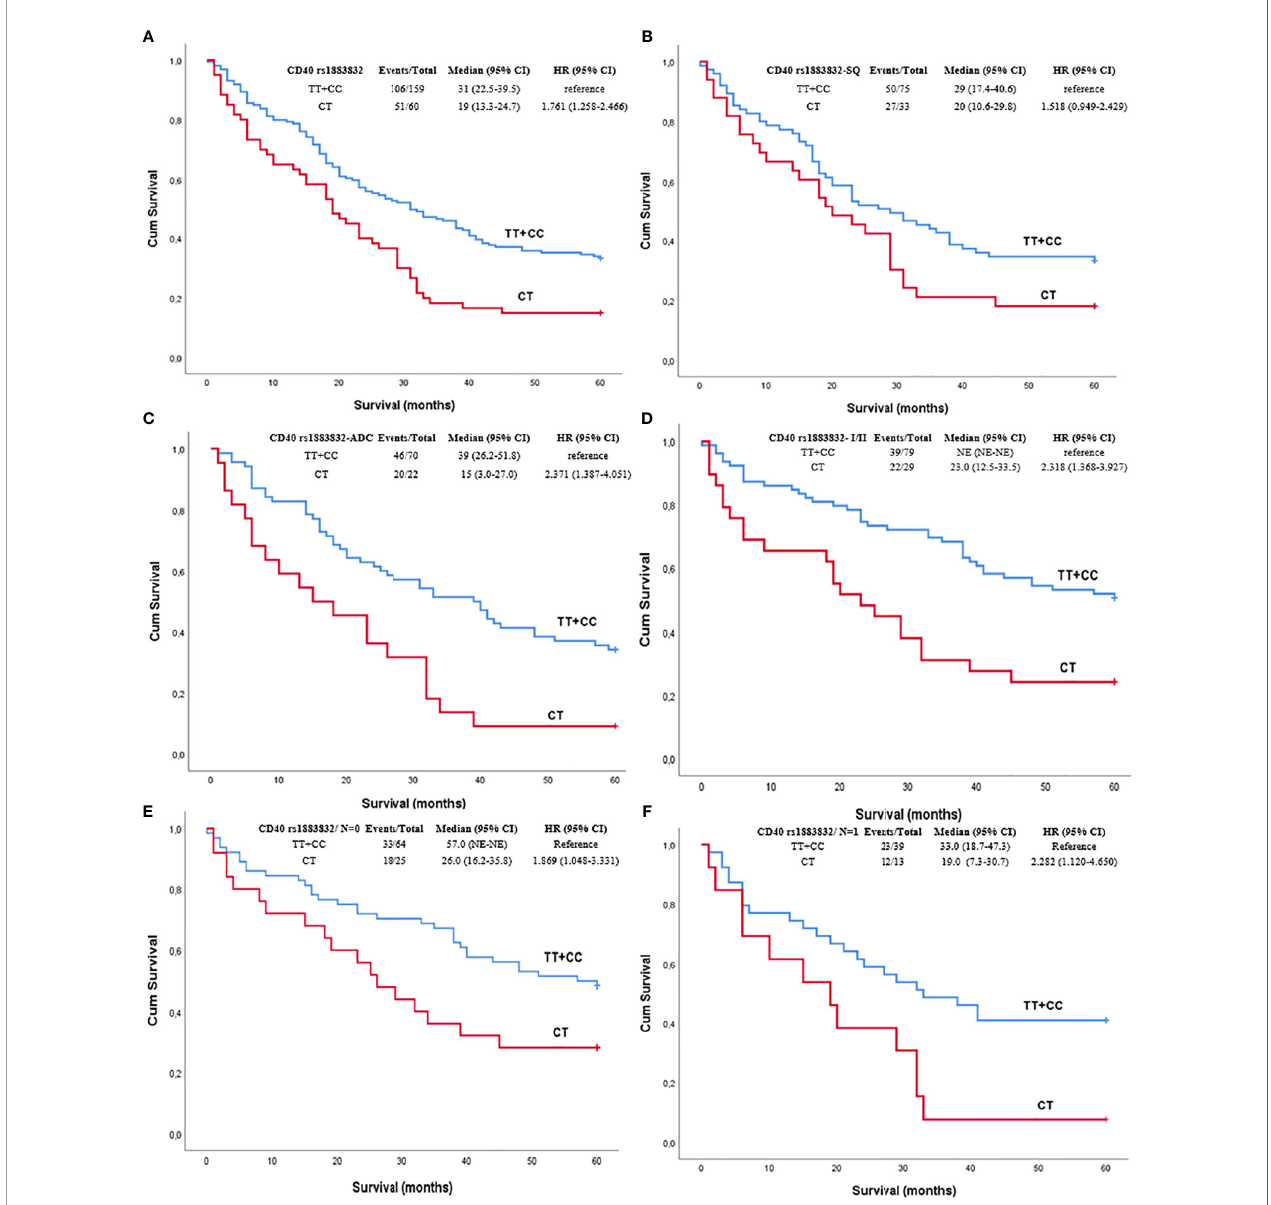
FIGURE 1 | Kaplan – Meier curves depicting overall survival (OS) of NSCLC patients in relation to (A) CD40 rs1883832 genotypes in the whole sub-cohort of NSCLC patients, (B) CD40 rs1883832 genotypes in SQ patients, (C) CD40 rs1883832 genotypes in ADC patients, (D) CD40 rs1883832 genotypes in stage I and II patients, (E) CD40 rs1883832 genotypes in NSCLC patients with N = 0, (F) CD40 rs1883832 genotypes in NSCLC patients with N = 1. SQ, squamous cell carcinoma; ADC,